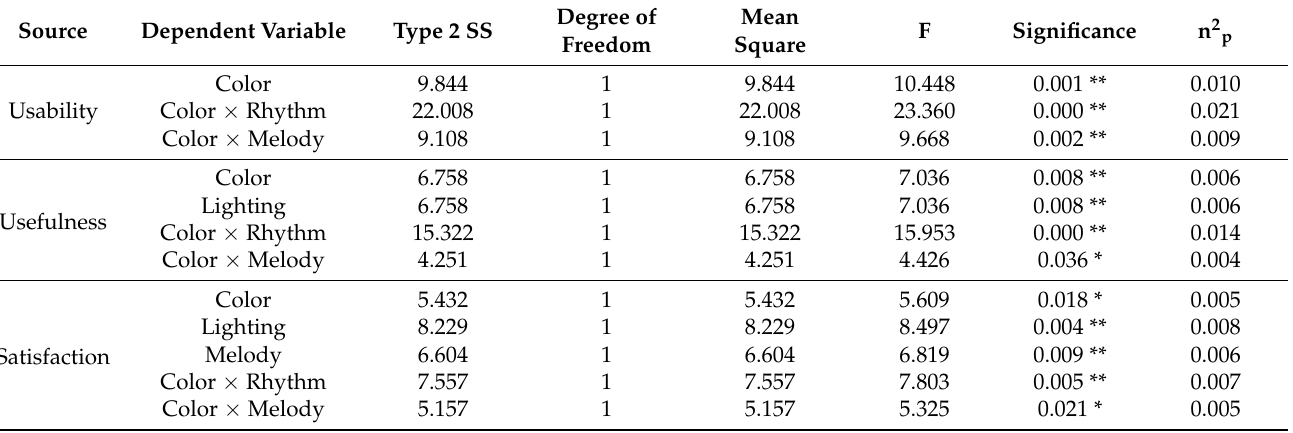
Table 6. Verification and analysis results of effects among different subjective cognitive combinations in deceleration